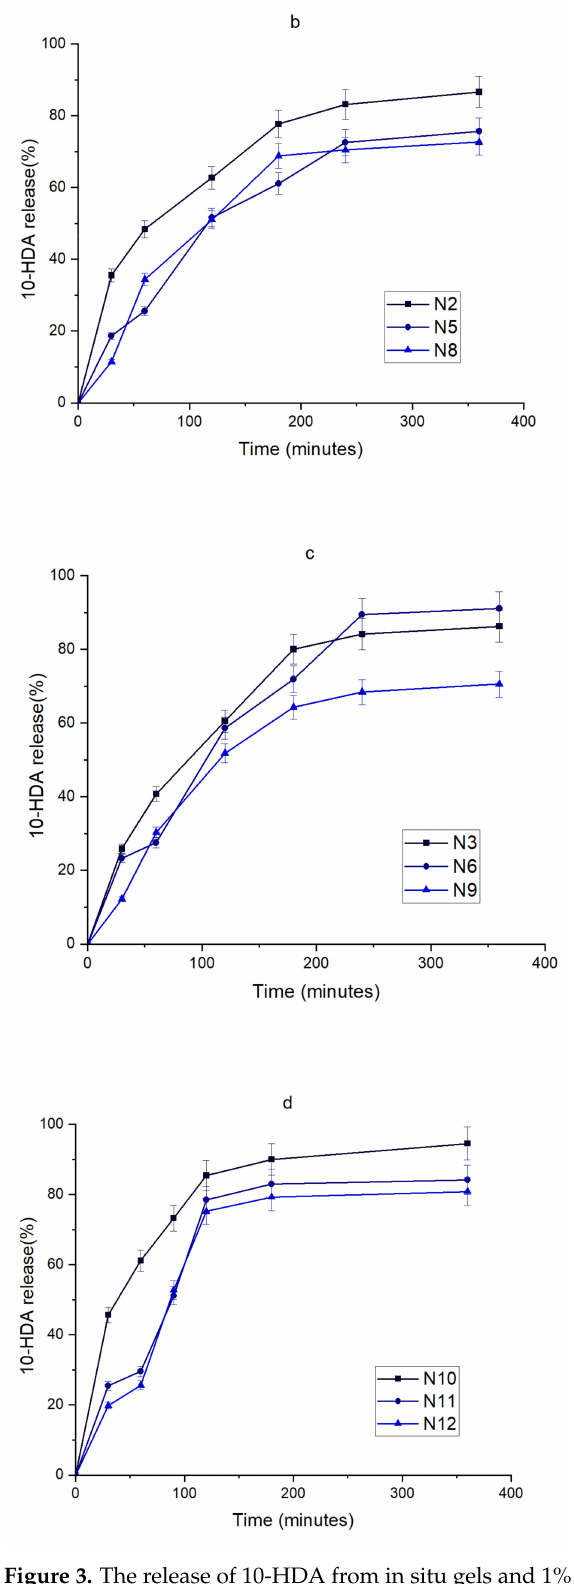
Figure 3. The release of 10-HDA from in situ gels and 1% RJ suspension. 1% RJ suspension and gel formulations N1–N3 ( a ), gels N4–N6 ( b ), gels N7–N9 ( c ), and gels N10–12 ( d ). Data represent mean standard deviation (SD), n =